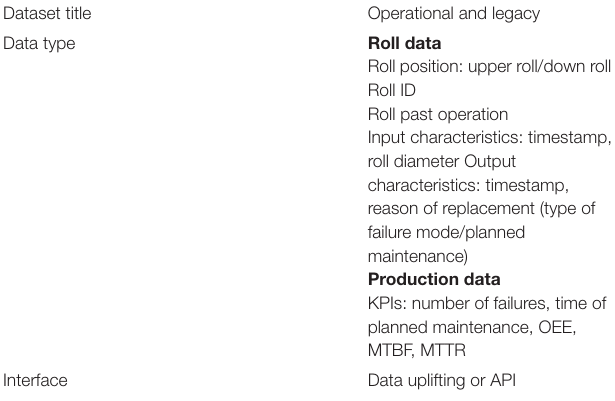
TABLE 5 | The CMMS dataset.